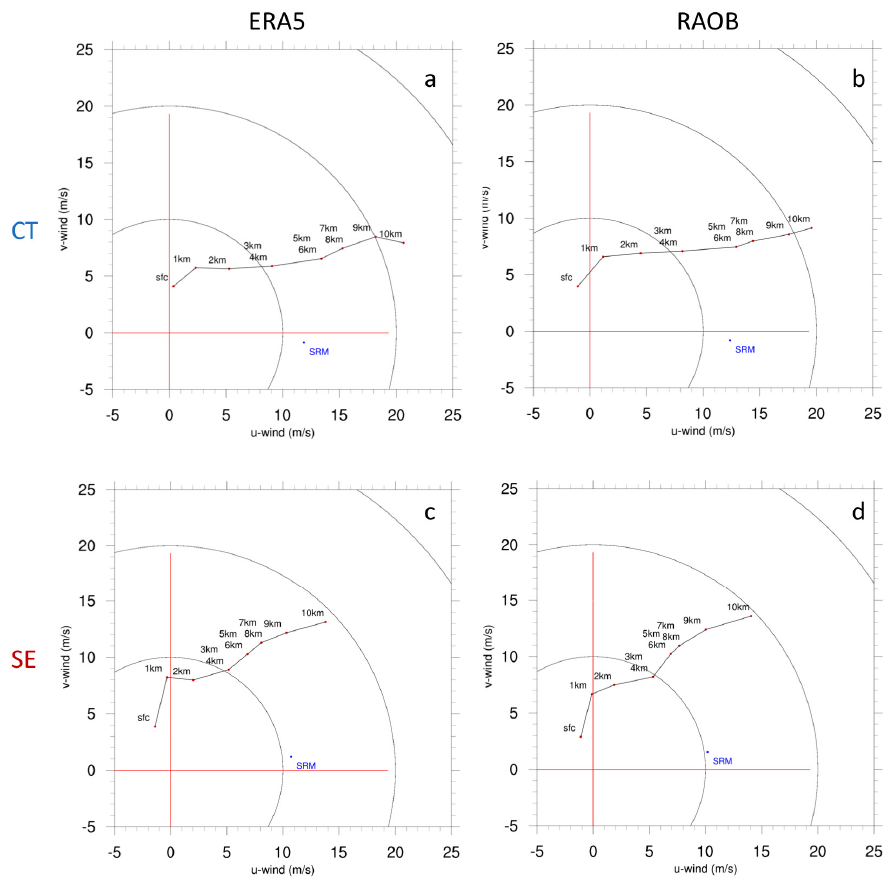
Figure 3. Composite hodographs at Pratica di Mare ( a , b ) and Brindisi/Galatina ( c , d ) from RAOB sounding ( b , d ) and from ERA5 reanalysis ( a , c ). The blue points near the x -axes represent the storm relative motion (SRM) (RAOB data source: Department of Atmospheric Science, University of